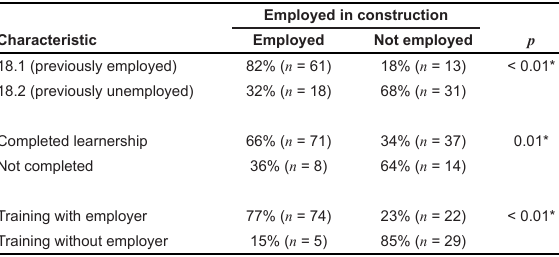
TABLE 6 Differences in learner groups – construction learner